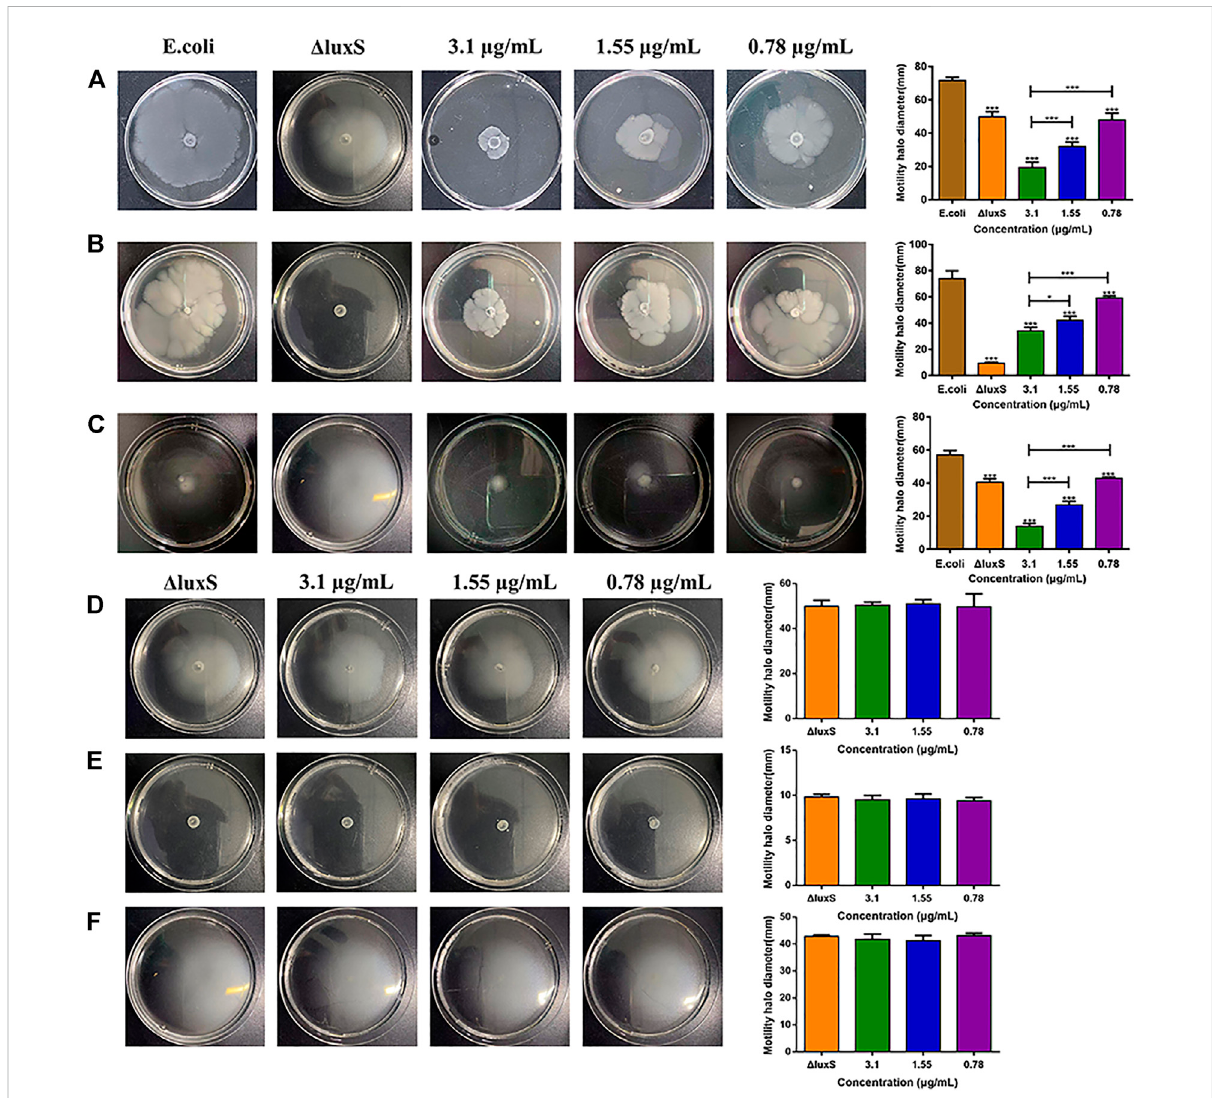
FIGURE 5 Effect of luxS gene deletion and 1,8-cineole on bacterial motility . (A – C) Effect of luxS gene deletion and non-inhibitory concentrations of 1,8- cineole on the swimming motility, swarming motility and twitching motility of E. coli O101. (D – F) Effect of non-inhibitory concentrations of 1,8- cineoleontheswimmingmotility,swarmingmotilityandtwitchingmotilityof E.coli O101without luxS gene.Theresultsrepresentmeans±standard deviations for three independent experiments. * p < 0.05, ** p < 0.01 and *** p < 0.001 versus the control